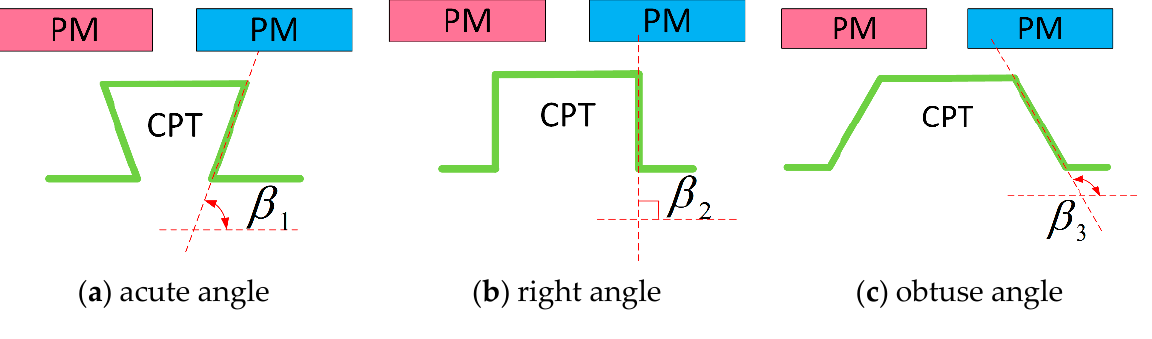
Figure 10. Shape of CPT. In order to clarify the effect of β on the cogging torque waveform of CPMLTM, the change of cogging torque waveform during the process of β from acute angle to obtuse angle was calculated using FEM. The relationship curve between β and the cogging torque peak is shown in Figure 11. The cogging torque waveform of CPMLTM when β is acute, right angle, and obtuse angle are shown in Figure